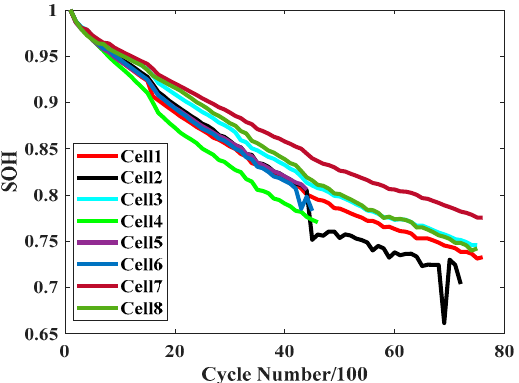
Figure 1. The capacity degradation curves of eight cells in the Oxford